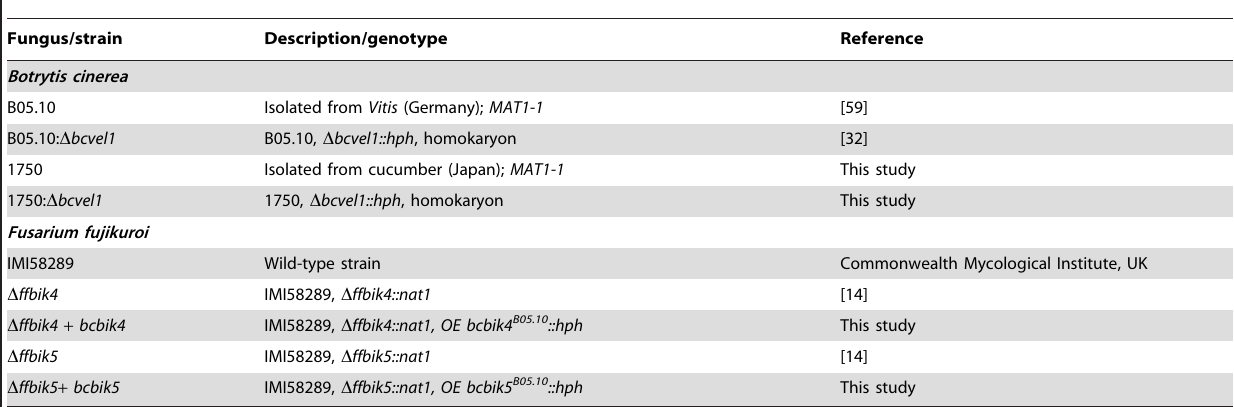
Table 2. Fungal strains used in this study for genetic